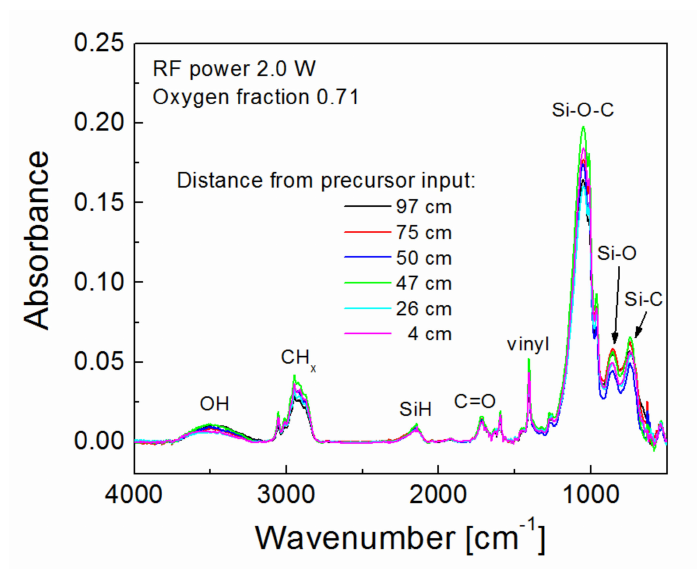
Figure 6. Infrared spectra for plasma nanocoatings on silicon wafers distributed along the tubular reactor for selected deposition